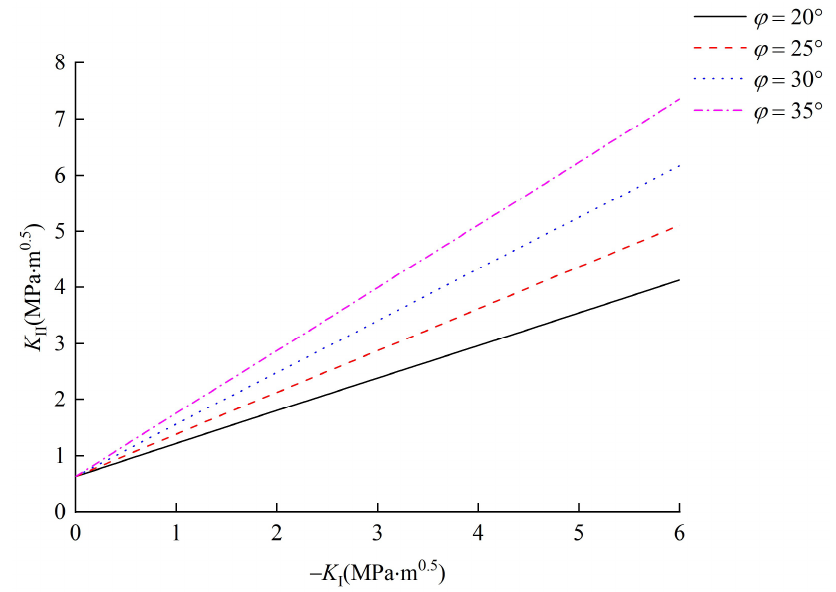
Figure 11. Effect of ϕ on the initiation of interface crack.